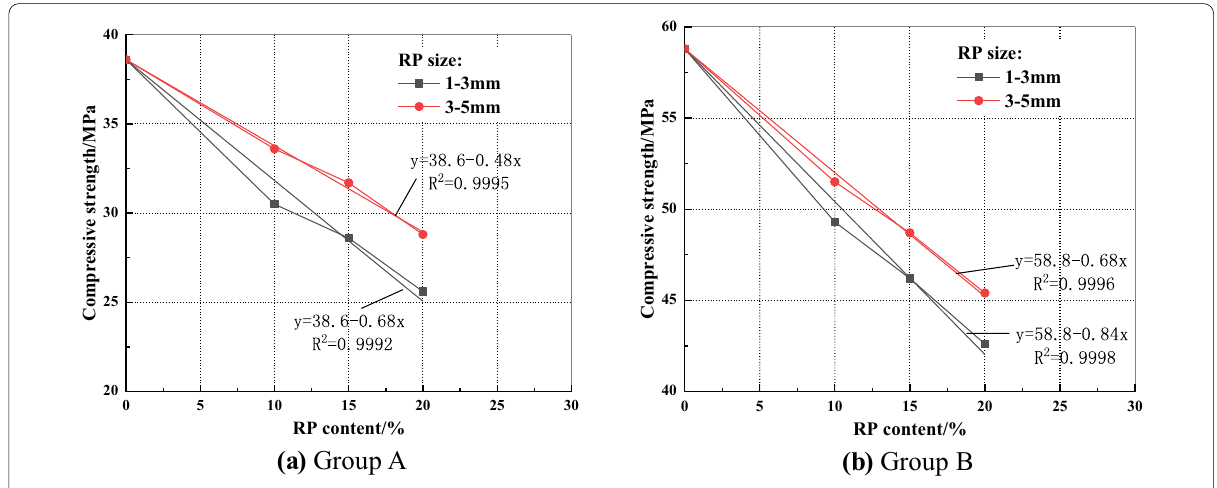
Fig. 6 Relationship between the compressive strength of concrete and RP content